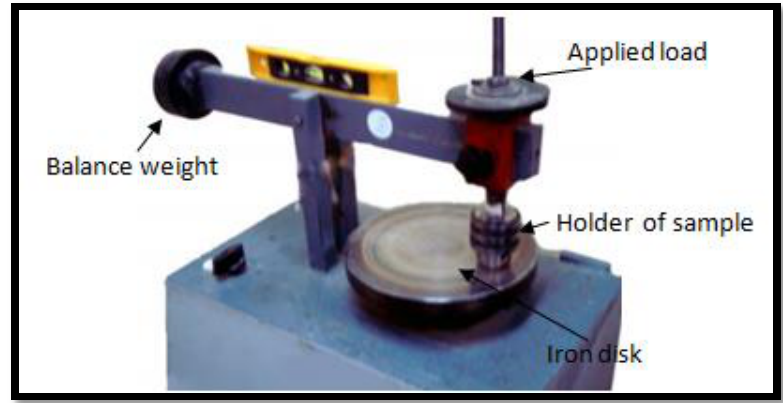
Fig. 3: Sliding wear